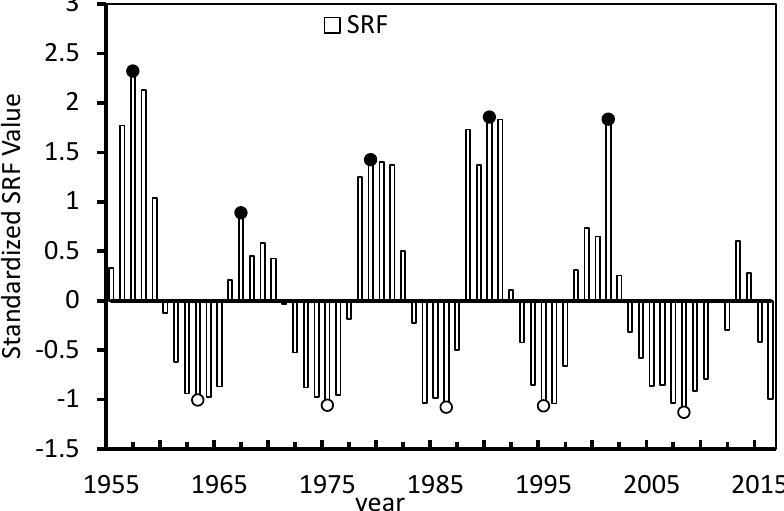
Figure 2. Time series of standardized SRF data with the solid (empty) circles representing peak (valley) years of SA (Song et al., 2016).( ● represents the peak year of solar activity, and ○ represents the valley year of solar activity.).